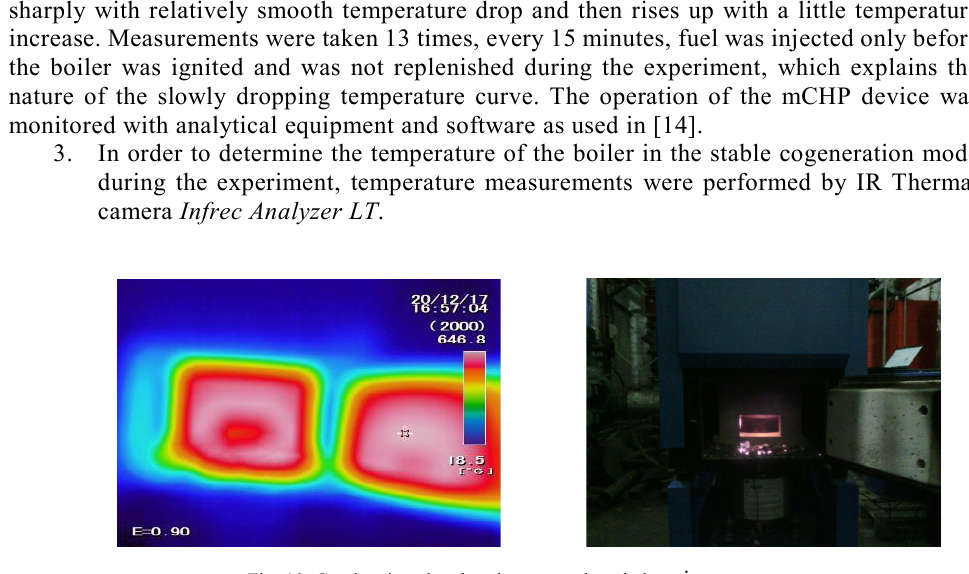
Fig. 10 . Combustion chamber thermograph and photo i